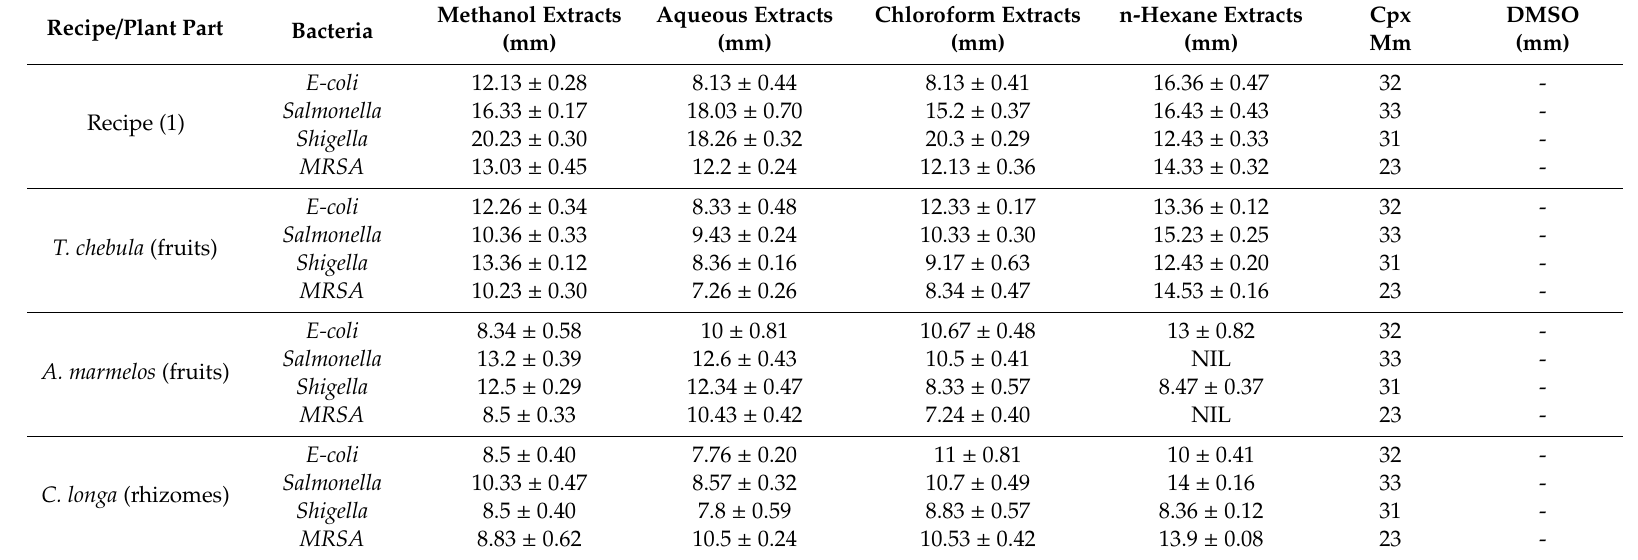
Table 4. Comparative Antibacterial Activities of methanol, Aqueous, Chloroform and n-hexane extracts of the T. chebula (fruits), A. marmelos (fruits), C. longa (rhizomes) and their recipe